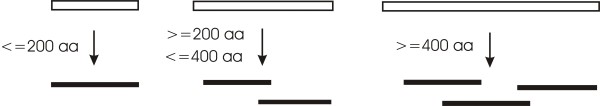
Fragmentation procedure of plant protein sequences in order to expand the EST-peptide dataset. Open bars, full-length proteins; filled bars, fragmented protein sequences. Proteins shorter than 200 residues remained unchanged. Proteins ranging from 200 to 400 residues were fragmented into two pieces. Proteins longer than 400 residues were fragmented into three pieces. See text for details.